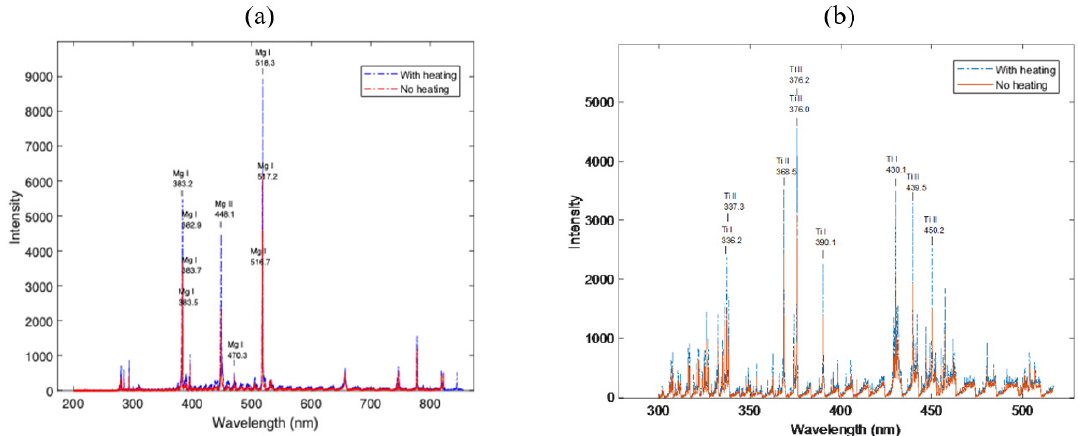
Figure 3. (a ) Laser induced breakdown spectroscopy (LIBS) spectra of Mg plasma with sample temperature of 100 °C and with no sample heating at a delay time of 12 µs and laser fluence of 12.9 J cm − 2 . ( b ) LIBS spectra of Ti plasma with sample temperature of 100 °C and with no sample heating at a delay time of 12 µs and laser fluence of 12.9 J cm − 2 .